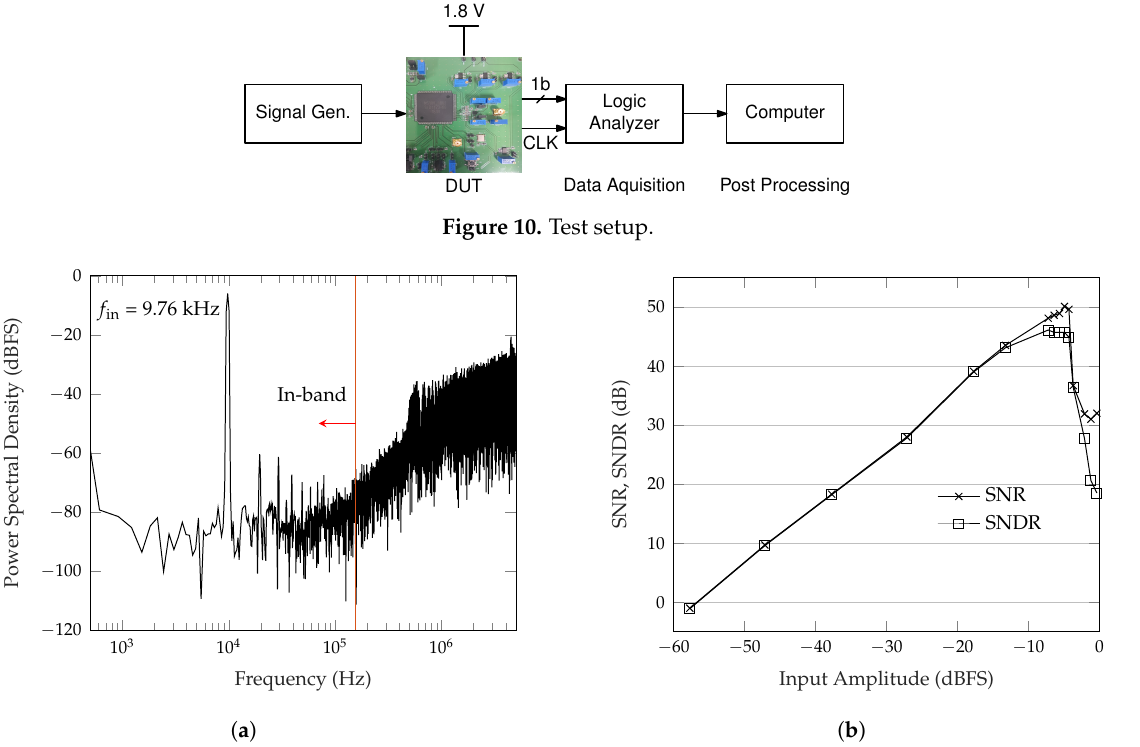
Figure 11. Measured results. ( a ) Power spectral density (# of fast Fourier transform (FFT) bins: 32768). ( b ) Signal-to-noise ratio (SNR) and signal-to-noise and distortion ratio (SNDR) versus input amplitudes.